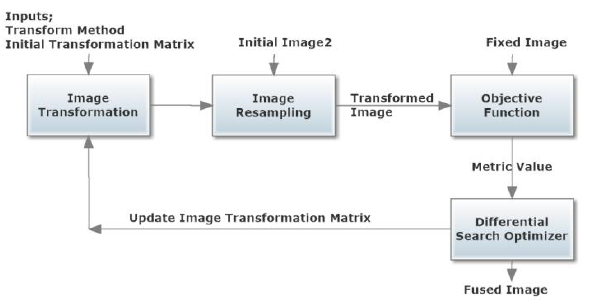
Figure 7: Proposed Method for image registration.